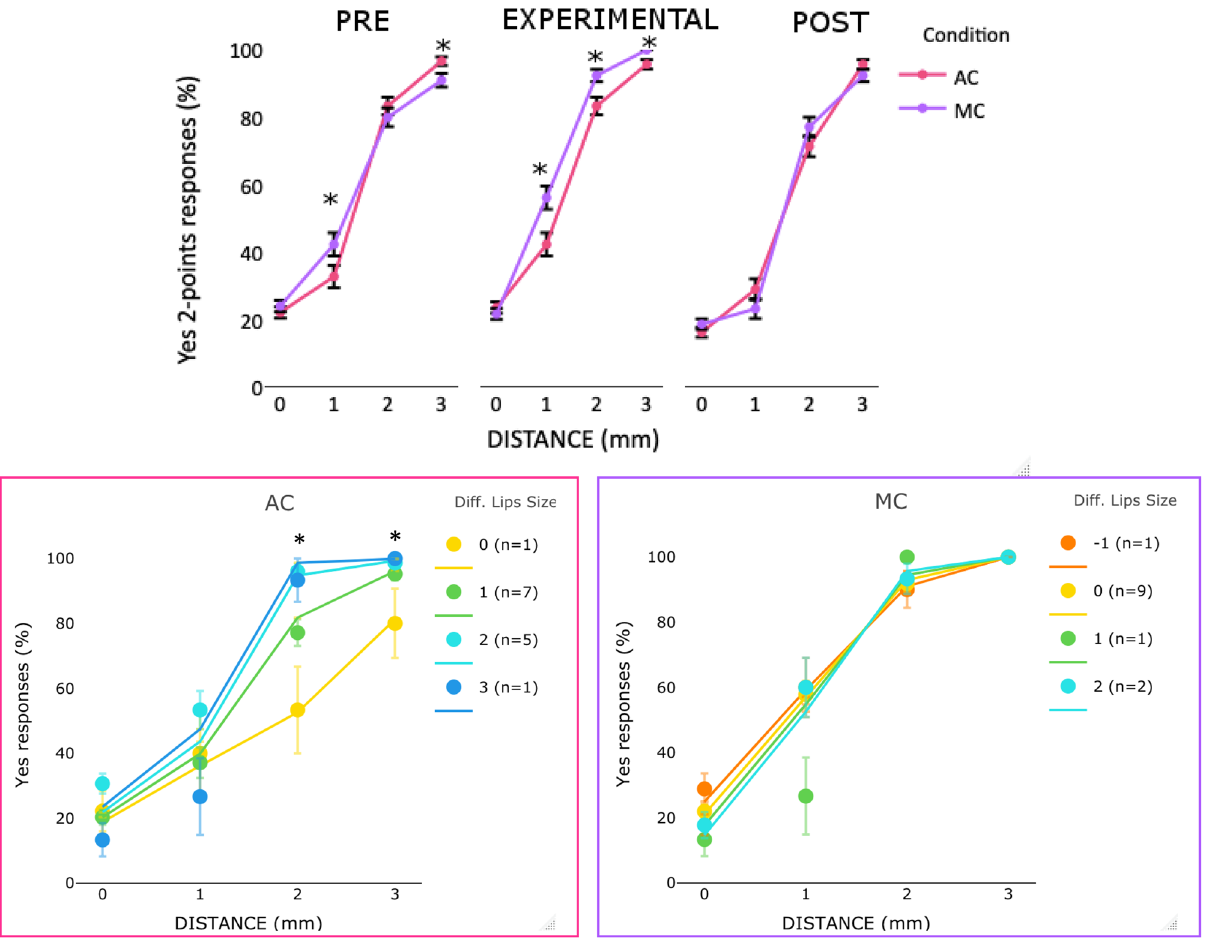
Figure 6. Top panel, mean (markers) and SE of the means (error bars) of yes responses in two points discrimination in PRE, EXPERIMENT and POST conditions for AC and MC at each distance (0, 1, 2, 3 mm) in Experiment 3. Bottom panel, mean and SE of the means (error bars) of yes responses in 2PD for AC (left panel) and MC (right panel) conditions as a function of distance (0, 1, 2, 3 mm) between 2 points and the change in the perceived lip size (whole face rating) in Experiment 3. The legend describes the amount of perceived change in the lip size and the number of individuals who perceived that change. Negative numbers indicate a perceived decrease and positive numbers indicate an increase in the perceived lip size compared to PRE. In the bottom row plots, colored lines represent the estimated effects in the LMM analyses and the markers the performance of individuals in the EXPERIMENT based on change in the perceived lip size in that condition with respect to the